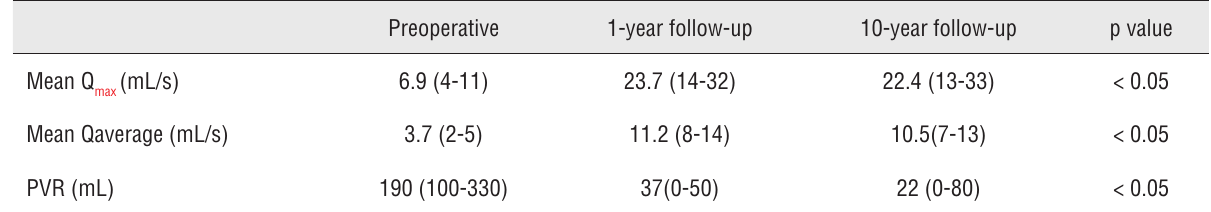
Table 2 - Uroflowmetry and PVR measurements preoperatively, at the postoperative 1st and 10th year. Preoperative